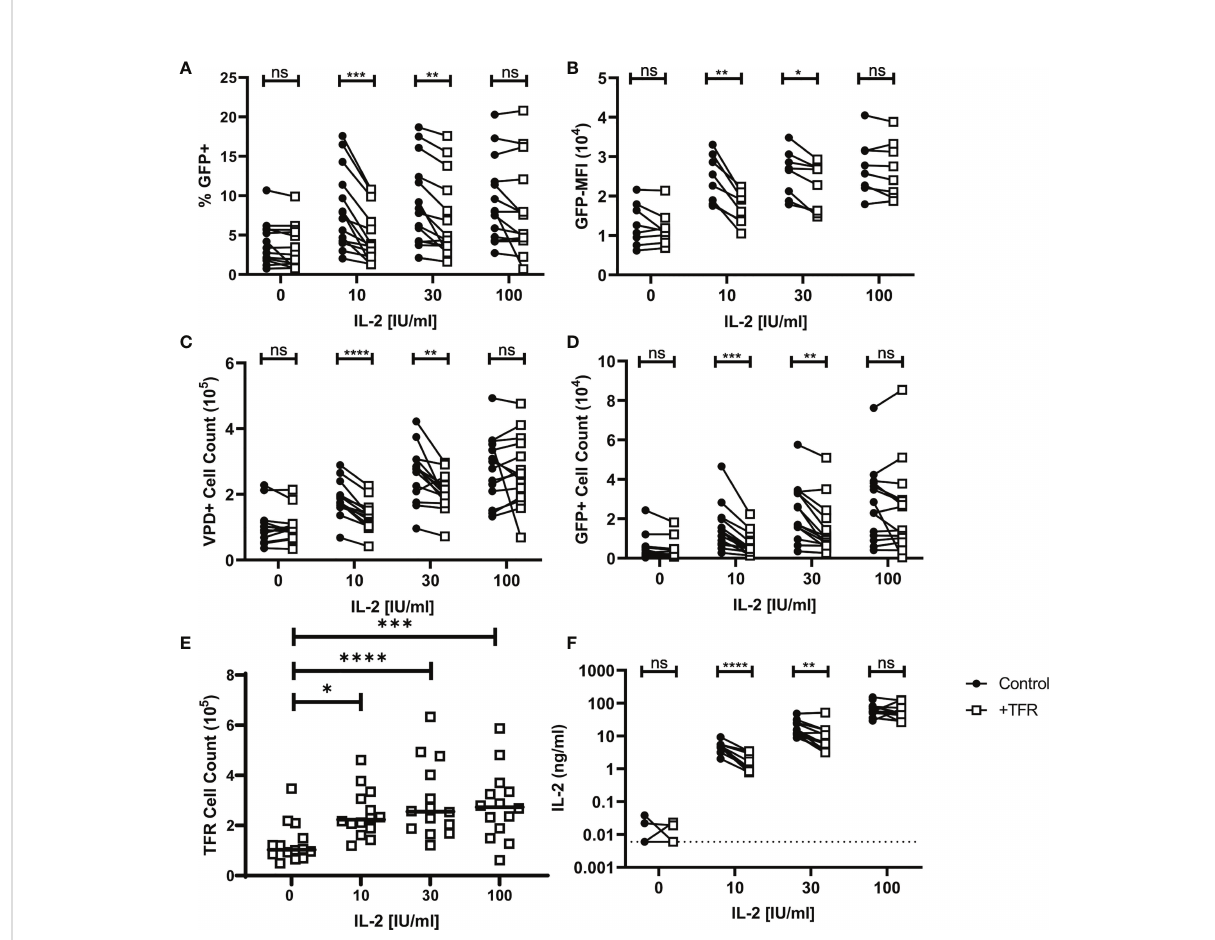
FIGURE 6 TFR reduction of HIV replication and TFH viability is IL-2 concentration dependent. TFH were spinoculated with CXCR4-tropic HIV, labeled with VPD, and cultured at a 1:1 ratio with unlabeled, uninfected TFH (Control) or TFR for 5 days with 5 m M saquinavir in the absence or presence of 10, 30, or 100 IU/ml IL-2. Percentages of GFP + VPD + TFH (A) , GFP MFI (B) , total VPD + TFH cell counts (C) GFP + VPD + TFH cell counts (D) , and TFR cell counts (E) were quanti fi ed via fl ow cytometry using absolute counting beads and the gating strategy in Figure 1 (n=14). (F) IL-2 concentrations from 12 of the TFH coculture supernatants were quanti fi ed by ELISA. Statistical analyses were performed using 2-way ANOVA and Sidak ’ s multiple comparisons tests (A-D, F) , and Friedman and Dunn ’ s multiple comparison test (E) using Graphpad Prism v8 and signi fi cance as indicated: (ns) not signi fi cant p>0.05; *p<0.05; **p<0.01; ***p<0.001;